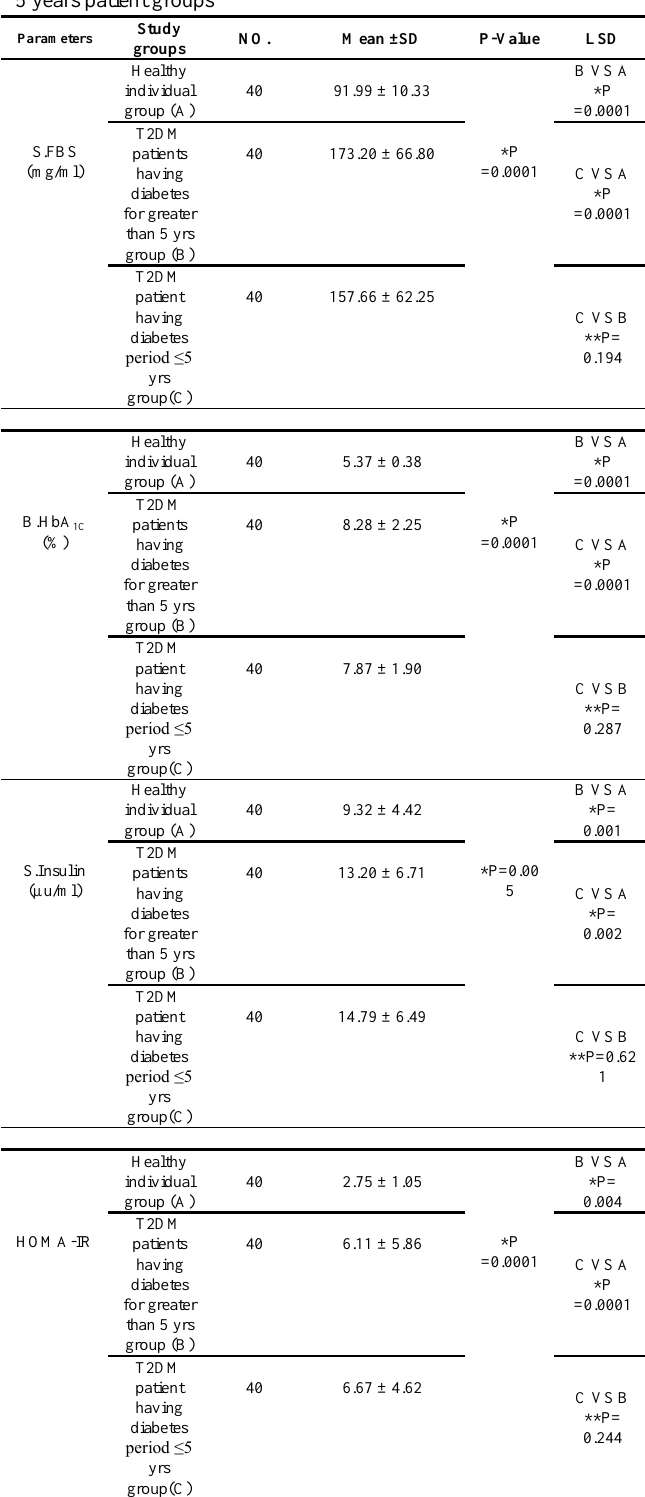
Table 1 : Mean ± Standard deviation (SD) of serum FBS, insulin, blood HbA1C and HOMA-IR in the Healthy individuals, T2DM with diabetes duration > 5 years, and T2DM with diabetes duration